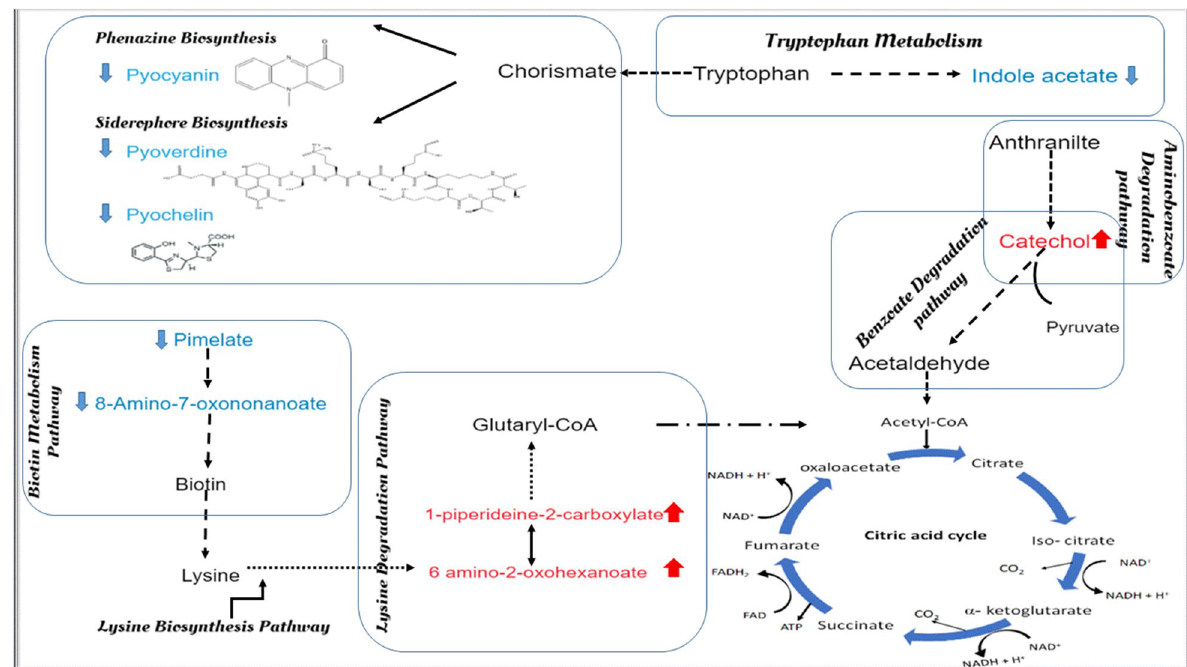
Fig. 8 A proposed scheme of the most important altered biochemical pathways of P. aeruginosa upon treatment with micafungin. Up‑regulated metabolites are shown in red arrow, down‑regulated metabolites are shown in blue arrow, dashed arrows indicate multiple enzymatic reaction